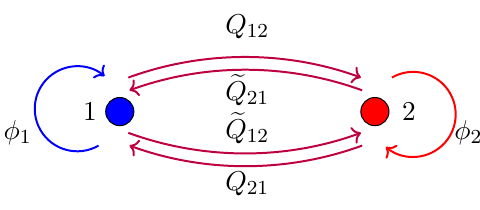
Figure 1 . The Z 2 quiver. The color groups are denoted by blobs representing the field content of the N = 1 vector multiplets inside the N = 2 vector multiplets. We use N = 1 language for the hypermultiplets. The arrow to the right is Q ˆ I while the arrow to the left is ˜ Q ˆ I .